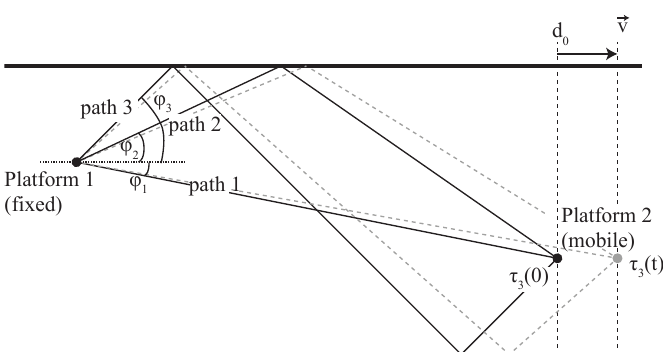
Figure 1. Representation of the multipath propagation behaviour in a shallow water mobile